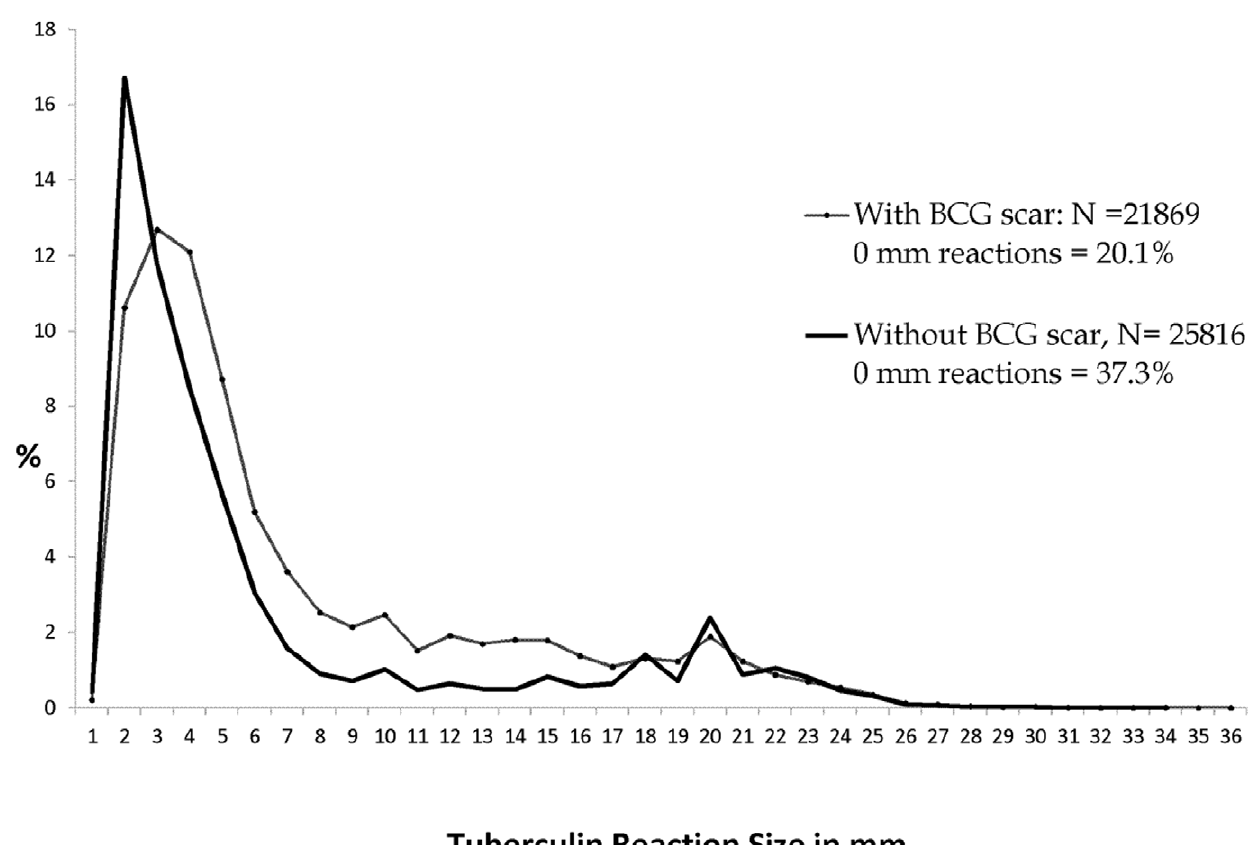
Figure 2. Frequency distributions of tuberculin reaction sizes by BCG scar status. Survey I ; Stratum: Both ; Age: 1–9 years.